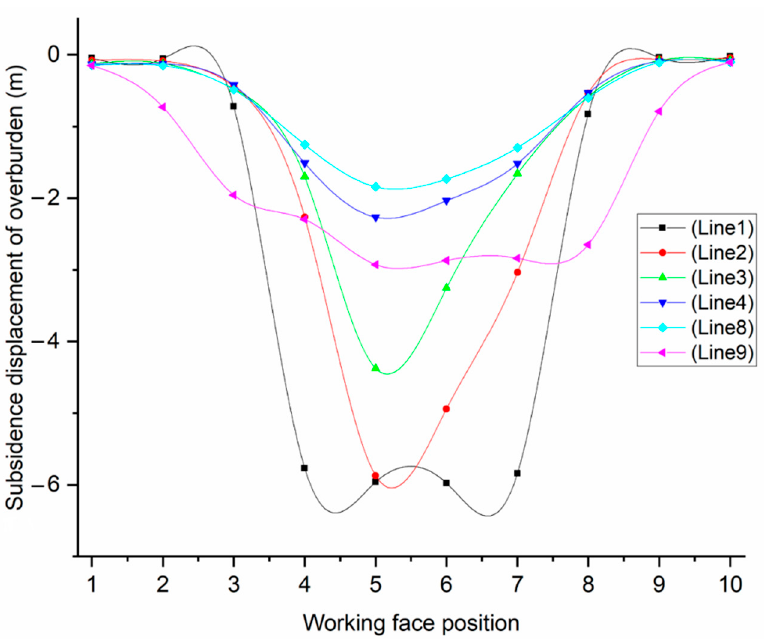
Figure 9. Overlying rock movement sinking curve of numerical simulation.